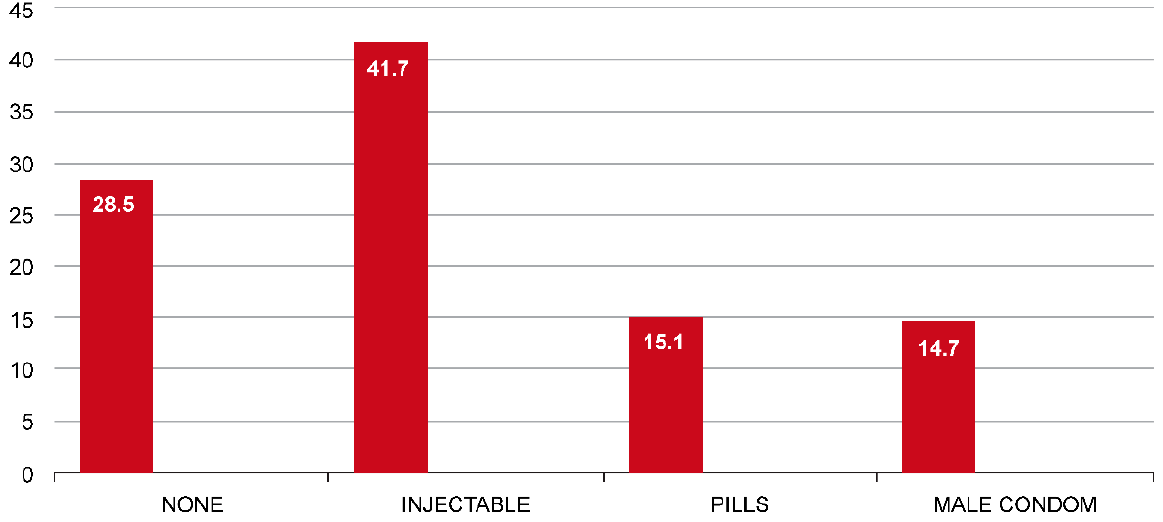
Figure 1. Current contraceptive methods used (in %) by Tanzania women if not using LARCs, 2015–2016.